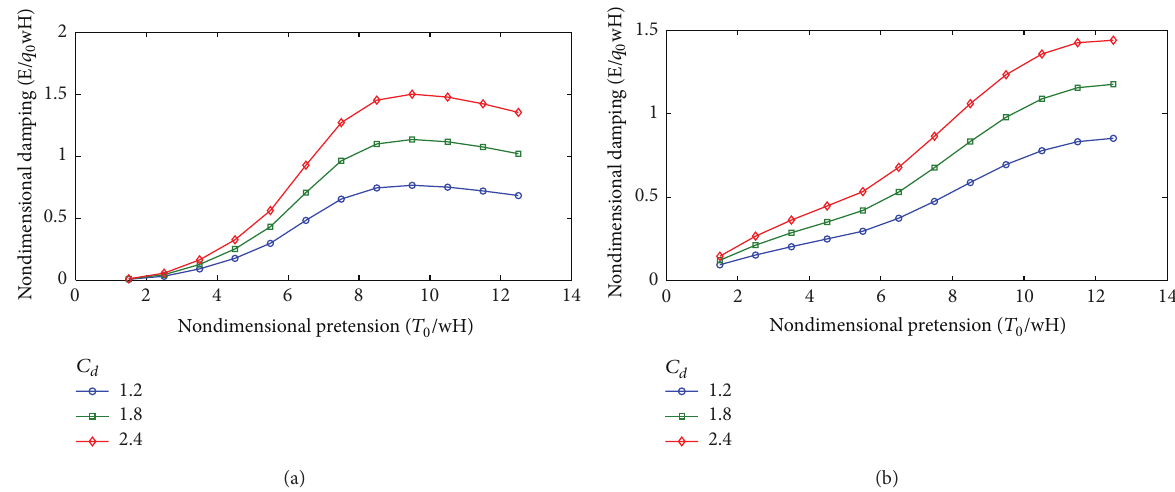
Figure 9: Variation of mooring line damping with drag coefficient. (a) Horizontal motions. (b) Vertical motions.